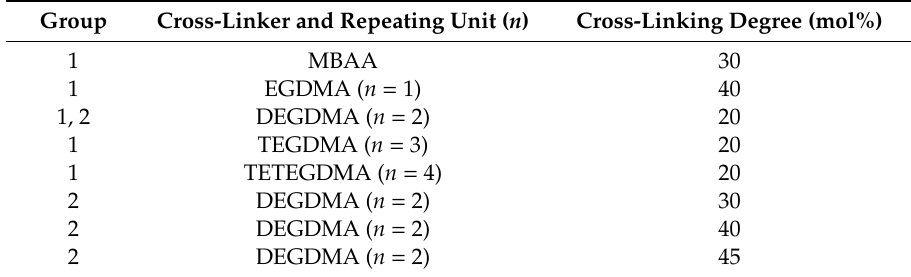
Table 1. The groups of poly(methacrylic acid) based on different types of cross-linkers and different degrees of cross-linking.